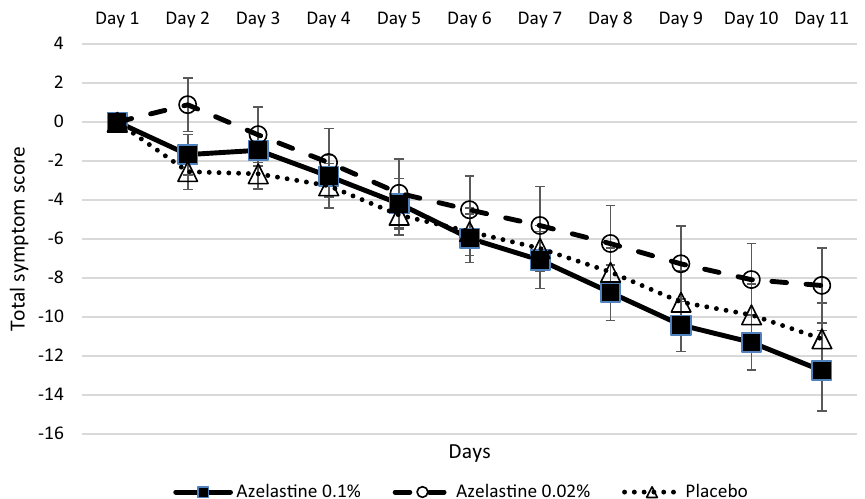
Figure 6. Absolute changes of total symptom scores from baseline (day 1) until day 11 of treatment (ITT analysis